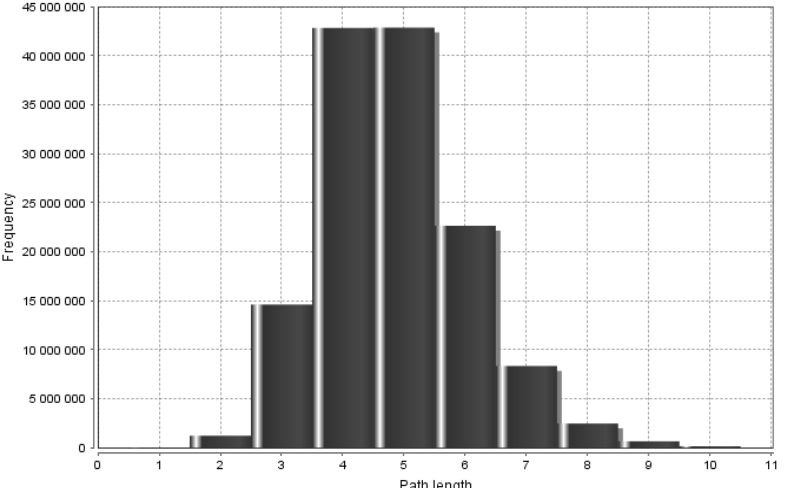
Fig. 1. The Frequency Distribution of the Shortest Paths in the